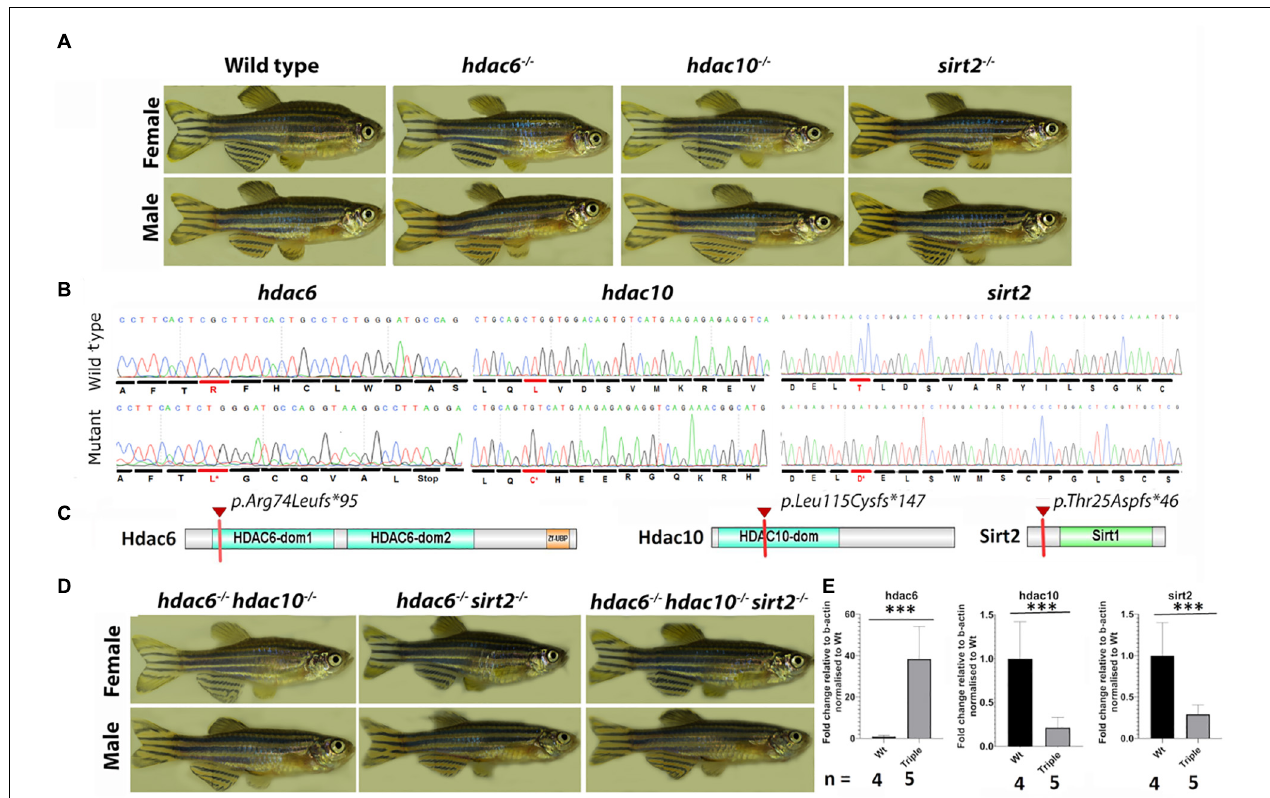
FIGURE 1 | 1.5-year-old zebrafish do not display any obvious external phenotype. (A) Pictures of single mutant fish were taken at 1.5 year – single mutation did not cause any visible abnormalities. (B) Comparison of wild type and mutated sequences for hdac6 and hdac10 and sirt2 genes, the first changed amino acid caused by frameshift is indicated in red. (C) Schematic representation of proteins of interest – the red mark shows the premature stop codon caused by the mutation. (D) External phenotypes of double mutants and triple mutants. (E) qPCR results showing expression levels for hdac6, hdac10, and sirt2, relative to b-actin level and normalized to wild type ( t -test *** p < 0.005).